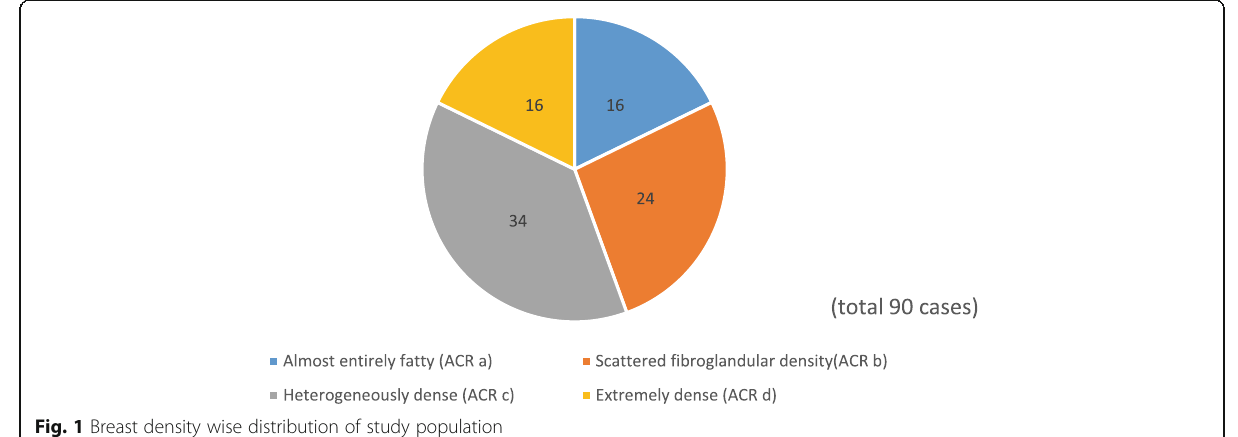
Fig. 1 Breast density wise distribution of study